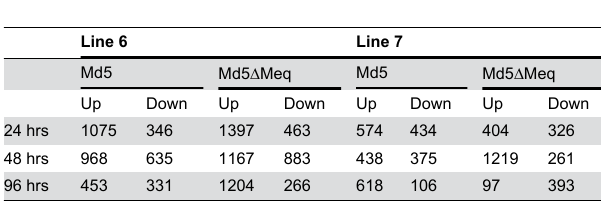
Table 1. Summary of differentially expressed genes in lines 6 and 7 using infection with virulent Md5 or avirulent Md5∆Meq.